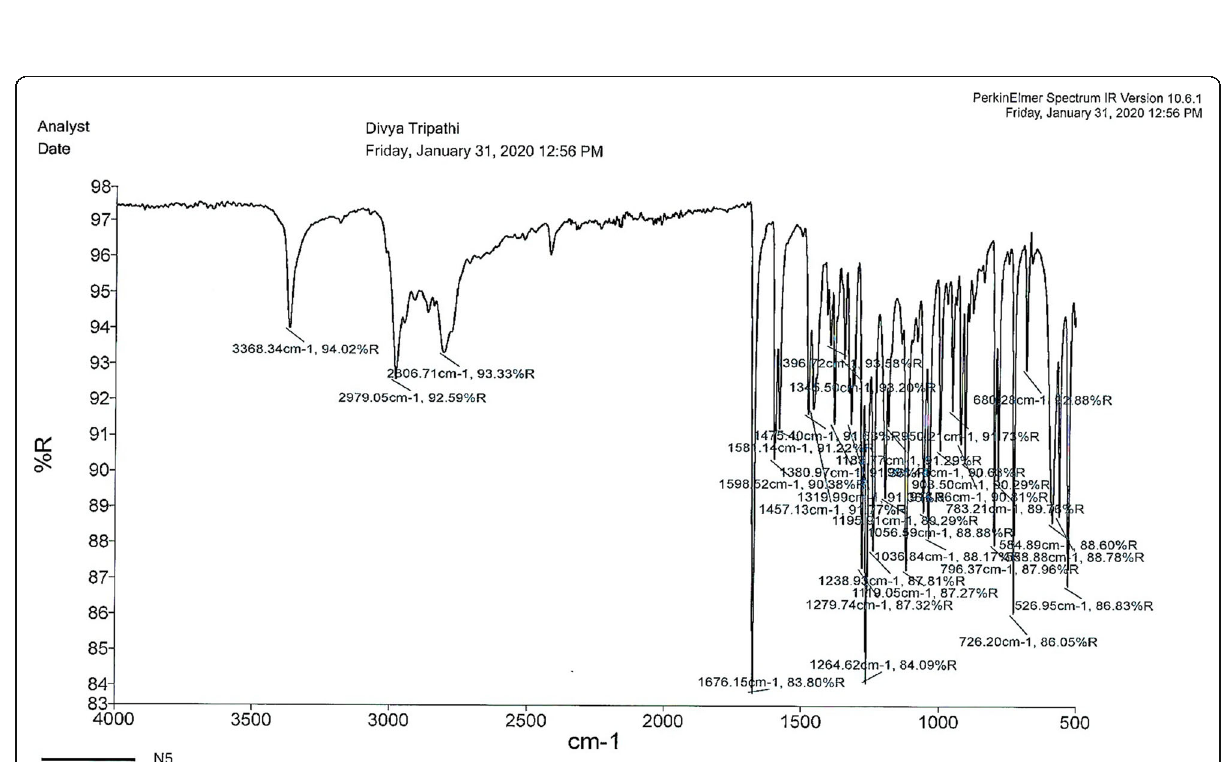
Fig. 6 FTIR spectra of physical